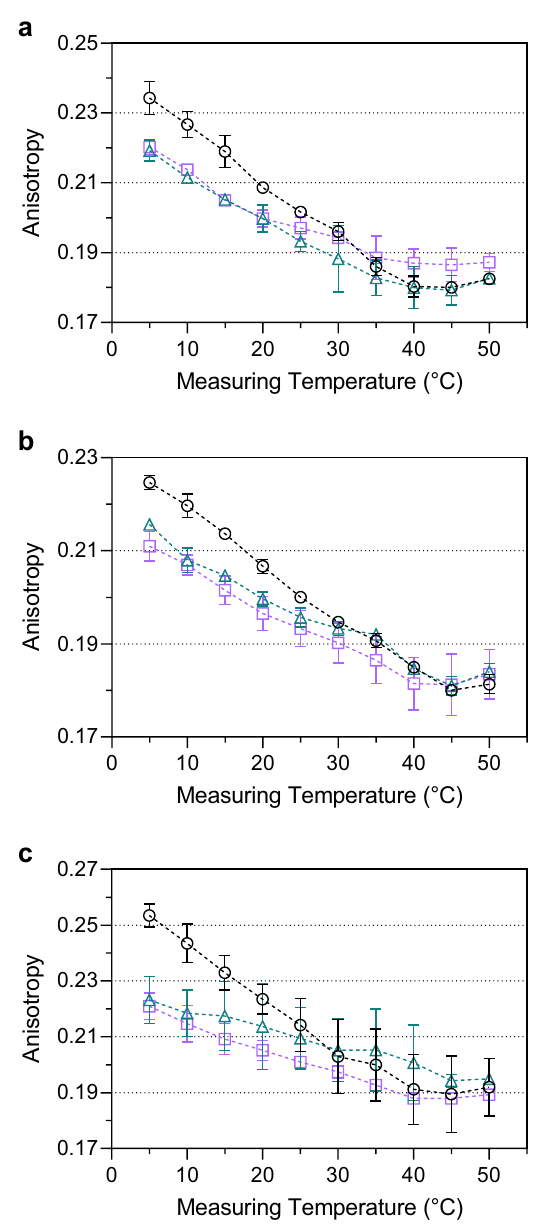
Figure 2. Analysis of membrane fluidity by TMA-DPH anisotropy. Listeria monocytogenes strains DSM 20600 T ( a ), FFH ( b ), and FFL 1 ( c ) grown at 6 °C in tryptic soy broth-yeast extract medium without supplementation (black circles), with 0.1% (wt/vol) of polysorbate 80 (green triangles), and with 0.1% (wt/vol) salmon lipid extract (purple squares). Values are means ± standard deviation ( n =